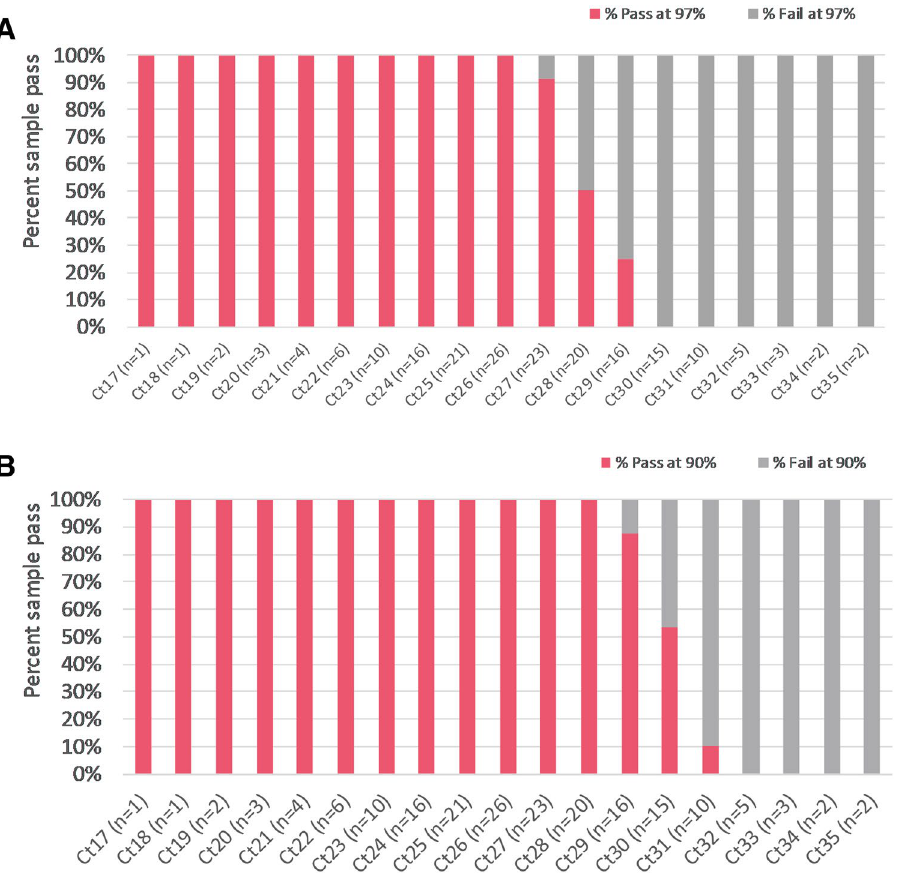
Figure 4. Sequencing pass rate (%) for Ct values between 17 and 35. Percent sample pass at over 97% consensus sequence coverage ( A ), and at over 90% consensus sequence coverage ( B ). Sample numbers tested per Ct are indicated in parentheses. Ct values were rounded